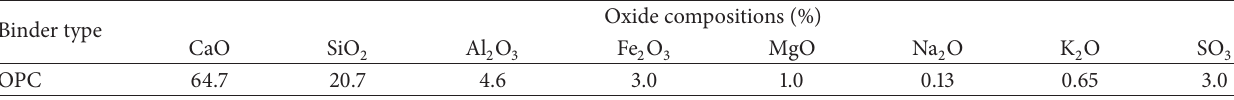
Table 1: Oxide composition of use